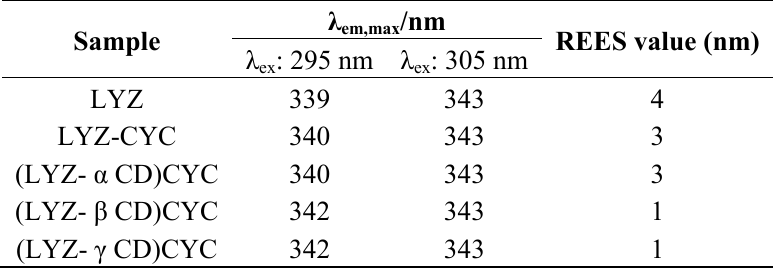
Table 2. Red edge excitation shift (REES) effects for LYZ and binary and